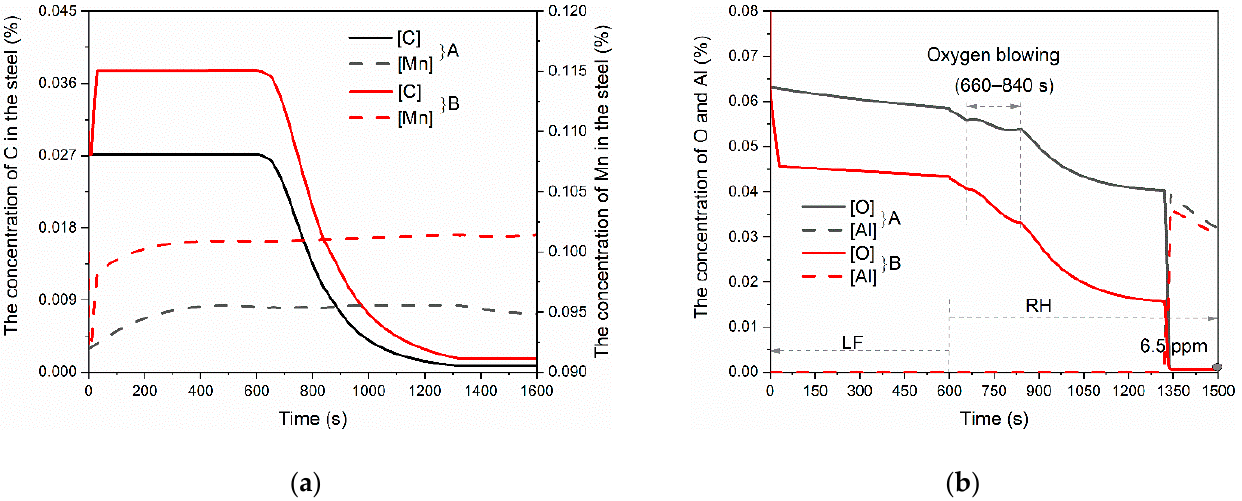
Figure 5. Comparing the steel compositions in the refining process ( a ) [C] and [Mn]; ( b ) Al and O (“[]” indicates dissolved value).